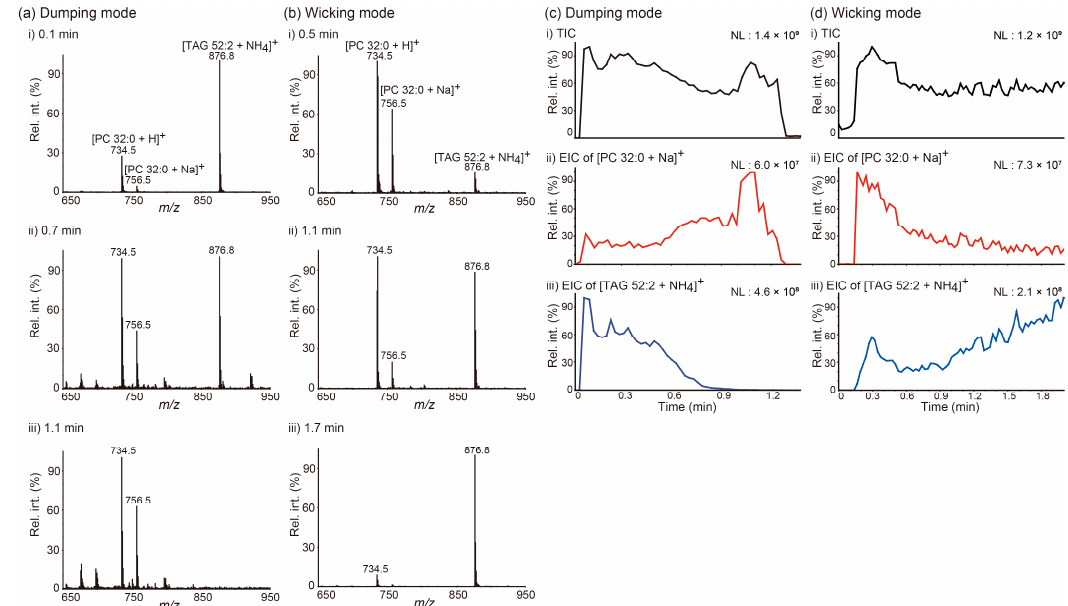
Figure 1. ( a and b ) Averaged paper spray ionization (PSI) mass spectra of a mixture of 1,2-dipalmitoyl- rac -glycero-3-phosphocholine (PC 32:0) and 1,3-dioleyl-2-palmitoyl-glycerol (TAG 52:2) at the indicated acquisition times. ( c and d ) i) Total ion chronograms (TICs) of PSI mass spectrometry analysis of a mixture of PC 32:0 and TAG 52:2 and extracted ion chronograms (EICs) for ii) the [PC 32:0 + Na] + ion at m/z 756.5 and iii) the [TAG 52:2 + NH 4 ] + ion at m/z 876.8. The PSI solvent (5 mM NH 4 Ac in MeOH) was applied either ( a and c ) in the dumping or ( b and d ) wicking modes. NL denotes the normalized level. MeOH: methanol; NH 4 Ac: ammonium acetate.